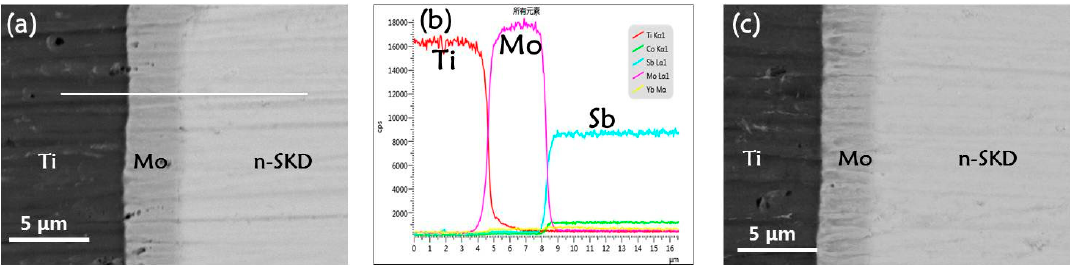
Figure 2. The interfacial microstructure of the Ti/Mo/Yb 0.3 Co 4 Sb 12 joints ( a ), as prepared, a Back Scattering Electron (BSE) graph, ( b ), as prepared, a line scan, and ( c ), after 10 cycles of thermal shocking between 0 °C and 600 °C, a BSE graph.